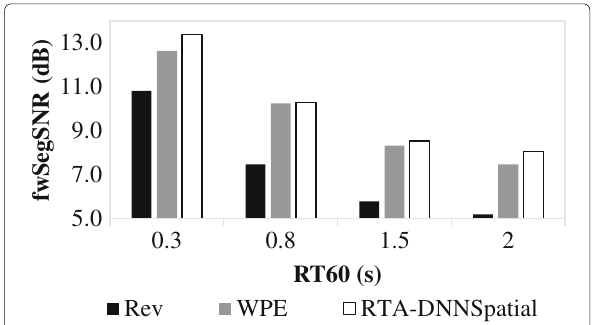
Fig. 11 Average fwSegSNR results at different RT60s, tested in a new array